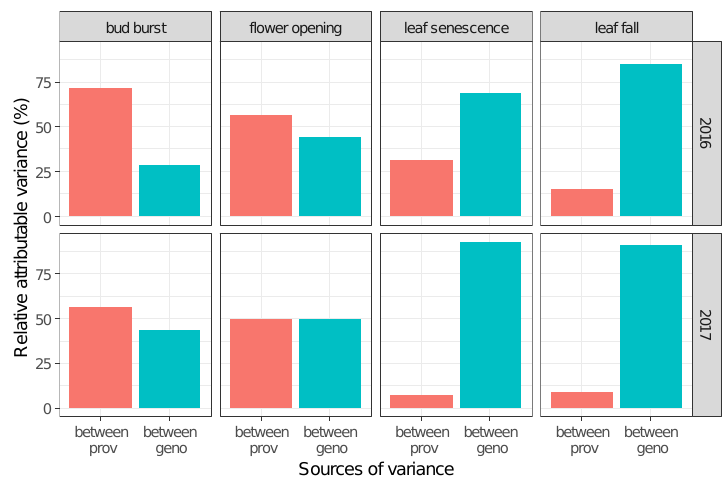
Figure 6. Relative between-provenance (between prov) and within-provenance (between geno) variance for the timing of bud burst, flower opening, leaf senescence and leaf fall in 2016 and 2017.